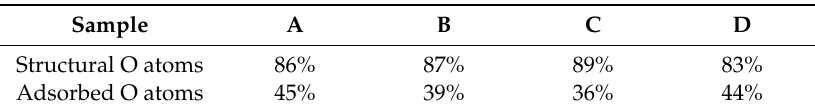
Table 3. Structural and adsorbed oxygen percentage of Sn atoms in SnO 2 nanoparticles within the system PEO (600,000 g/mol)–LiClO 4 (EO:Li + = 8)–SnO 2 ( d = 3–4 nm, weight ratio of SnO 2 :PEO = 0.05, 0.10, 0.15, 0.20). Adapted from Xiong et al. [105]. Samples B, C and D were obtained by calcining sample A (synthesized SnO 2 ) at 400, 600 and 800 °C for 3 h.